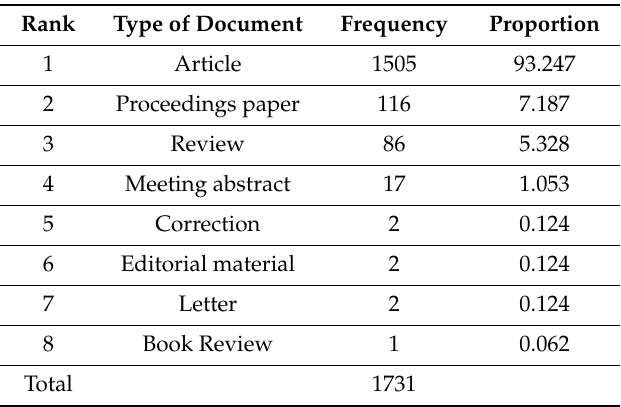
Table 1. Type of